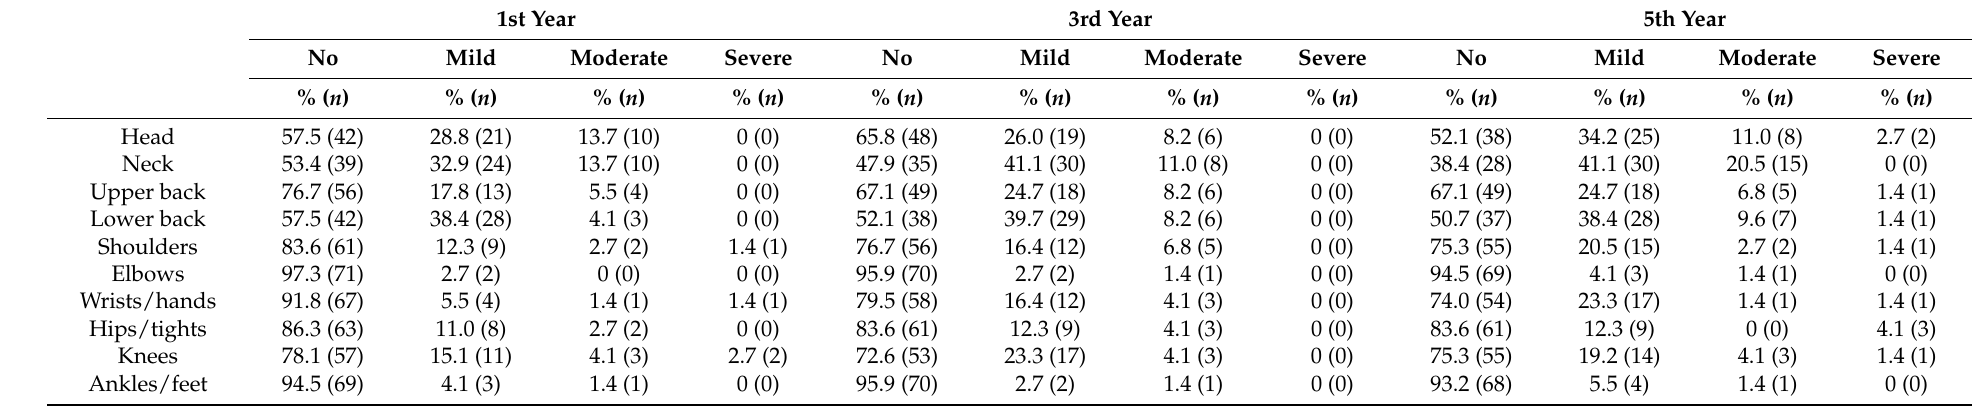
Table 1. The occurrence and intensity of recent pain in different body